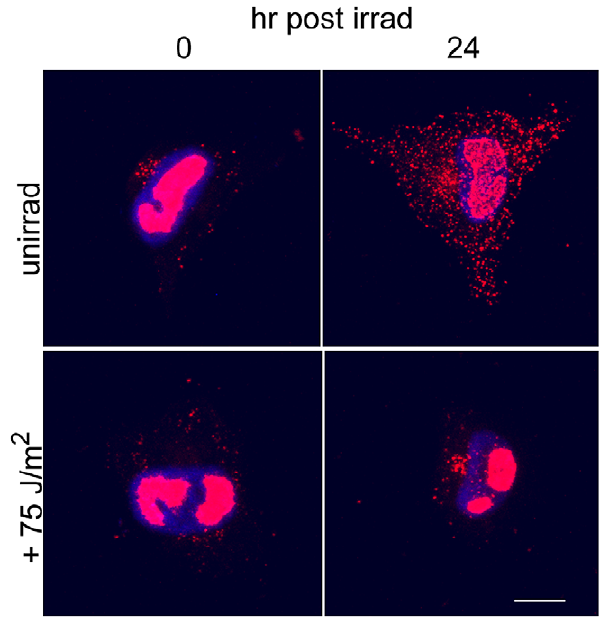
Figure 6. BrdU pulse and chase of viral DNA revealed no appreciable migration of pulsed viral DNA out of RCs during 24 h chase. HFFs were infected on coverslips. One h prior to irradiation at 48 hpi, infected cells were pulse-labeled with BrdU. One half of the coverslips were then irradiated with 75 J/m 2 . The second half was not irradiated. Timepoints were taken at 0 and 24 h post irradiation (or control treatment). Coverslips were fixed and stained for BrdU incorporation and imaged using confocal microscopy. Projection images of the entire stacks are shown, with Hoechst staining of the nuclei in